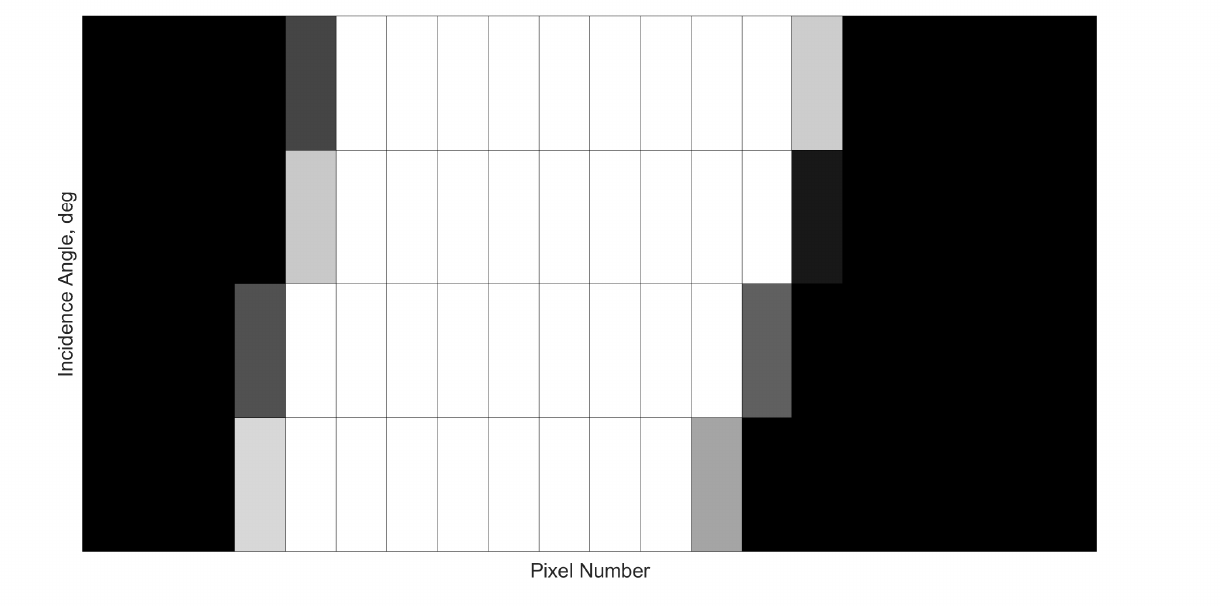
Figure 5. Zoomed-in pixel response to illustrate varying pixel illumination intensity at different incidence angles. The MLX75306 photodiode array used in this study consists of 144 pixels; except for the sanity pixels (1st and 144th pixel positions), each pixel can readout incidence intensity using a dedicated analog-to-digital converter (ADC) in either 1-, 2(1.5)-, 4- or 8-bit readout modes. Therefore, if a pixel is completely illuminated, the pixel would return values 1, 2, 15, or 255 depending on the readout mode. This, however, introduces a discretization error during hardware readouts. To illustrate using a 1-bit readout mode, a 65%-illuminated pixel would return a decimal value of 1, while a 45%-illuminated pixel would return a decimal value of 0. In contrast to the 8-bit readout mode, it would return decimal values